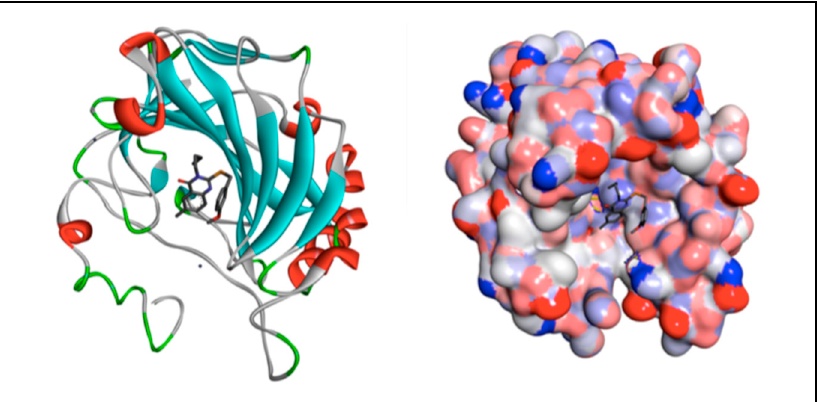
Figure 4 . Docking of one of the active compounds in the active site of human carbon anhydrase II (left) and the electrostatic surface potential of human carbon anhydrase II in complex with the active compound [32].